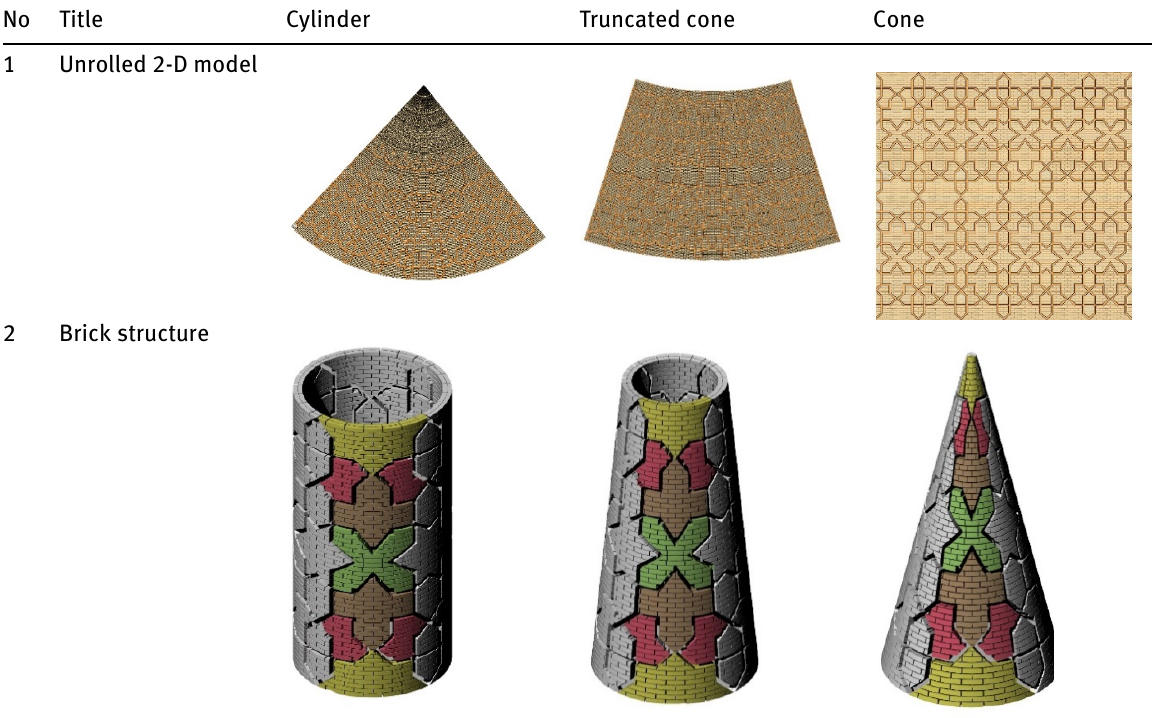
Table 4: The change process in girih pattern of the brickwork in the Sareban and Masjed-Ali minarets modeled on different 3-D shapes (cylinder, truncated cone, and